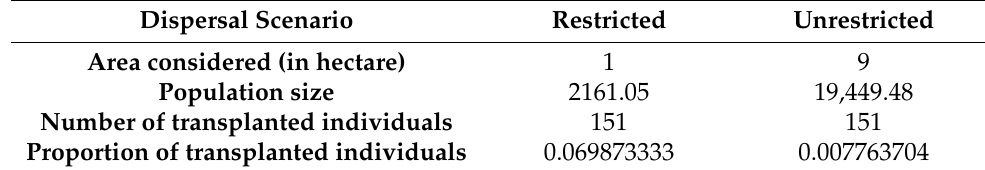
Table A5. Proportion of transplanted individuals in the Val Travers